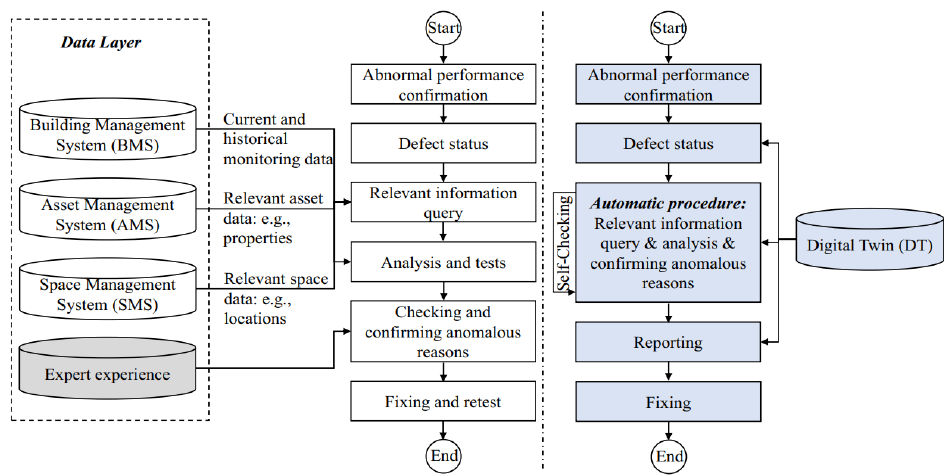
Figure 2. Traditional vs. Digital Twin-Driven Risk Management [17].